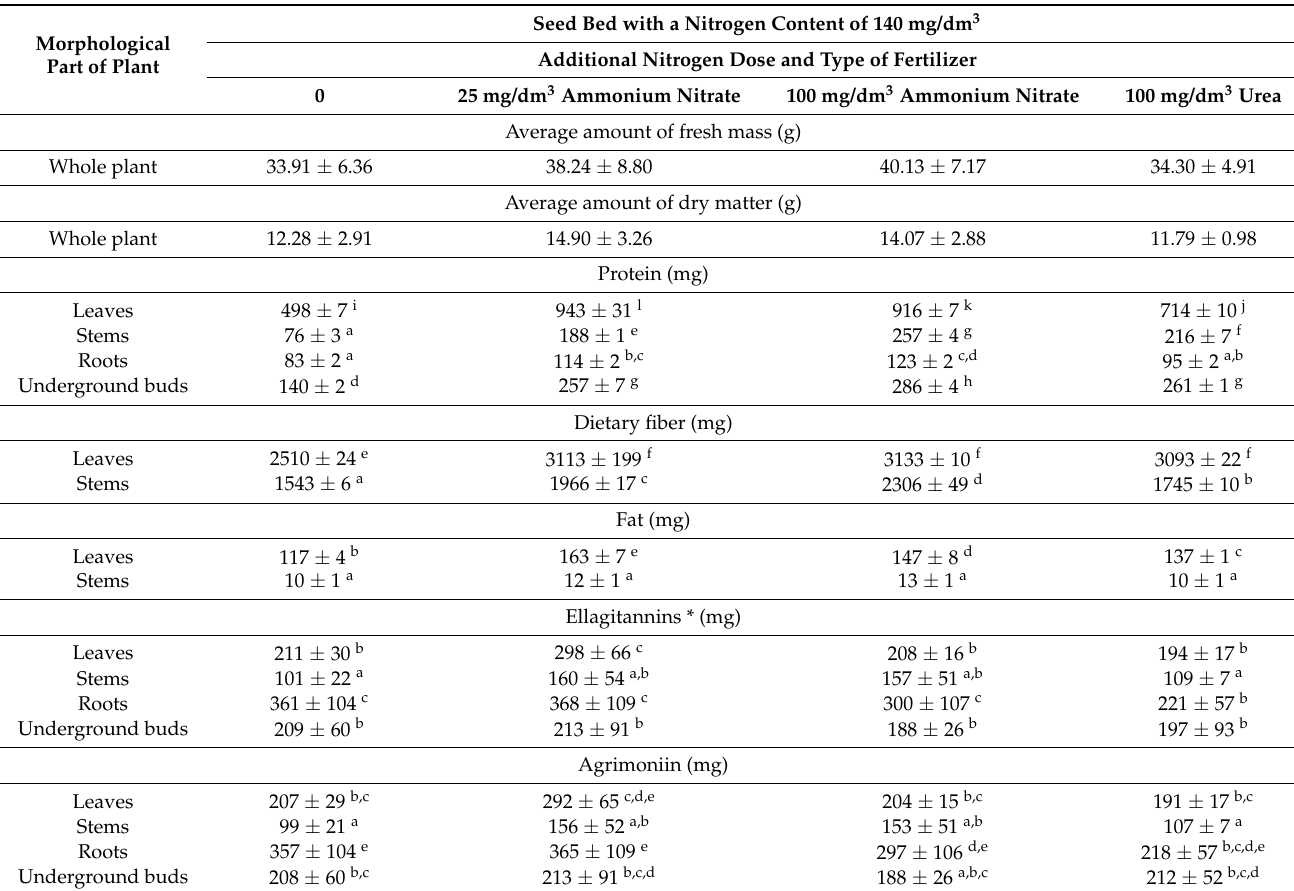
Table 4. Yield of dry matter, selected nutrients, and main groups of polyphenols in various morpho- logical parts of fragrant agrimony Agrimonia procera Wallr. from experimental